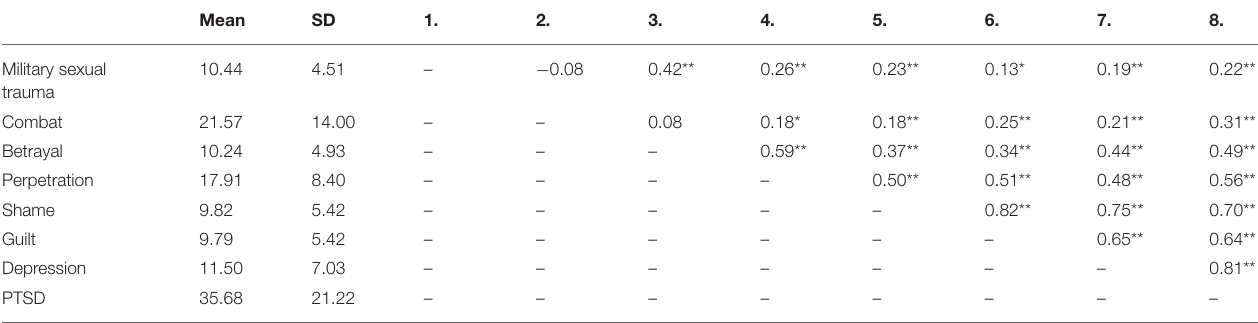
TABLE 1 | Descriptive statistics and